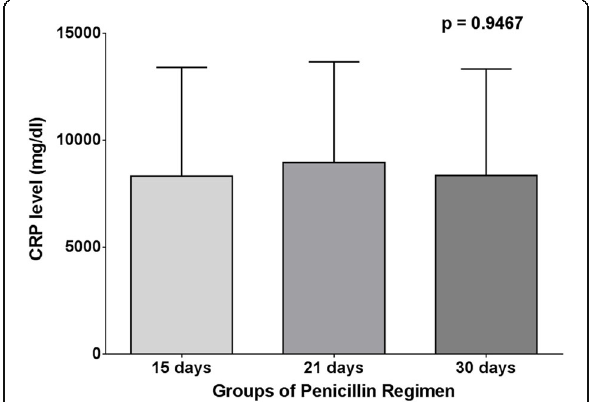
Fig. 9 One-way ANOVA test for CRP between penicillin and regimen groups